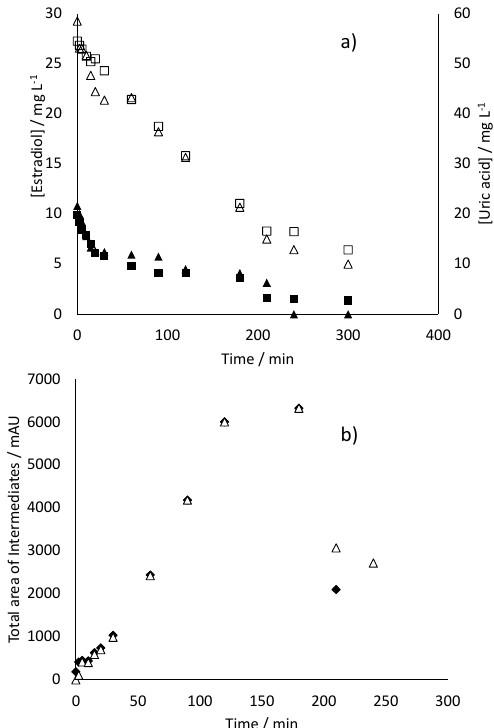
Figure 1. ( a ) Changes in the concentration of 17 β -estradiol (black symbols) and uric acid (white symbols) during the electrolysis with Boron Doped Diamond (BDD) anodes of 10 mg·L − 1 of 17 β -estradiol in methanol-urine solutions at 20 mA·cm − 2 of current density. Flowrate: ( ▲ , ) 8.66 mL·s − 1 ; ( ■ , □ ) 10.166 mL·s − 1 . ( b ) Totalized chromatographic area of reaction intermediates during the electrolysis of 10 mg·L − 1 17 β -estradiol in methanol-urine solutions at 20 mA·cm − 2 of current density. Flowrate: ( ♦ ) 8.66 mL·s − 1 ; ( ) 10.166 mL·s − 1 .